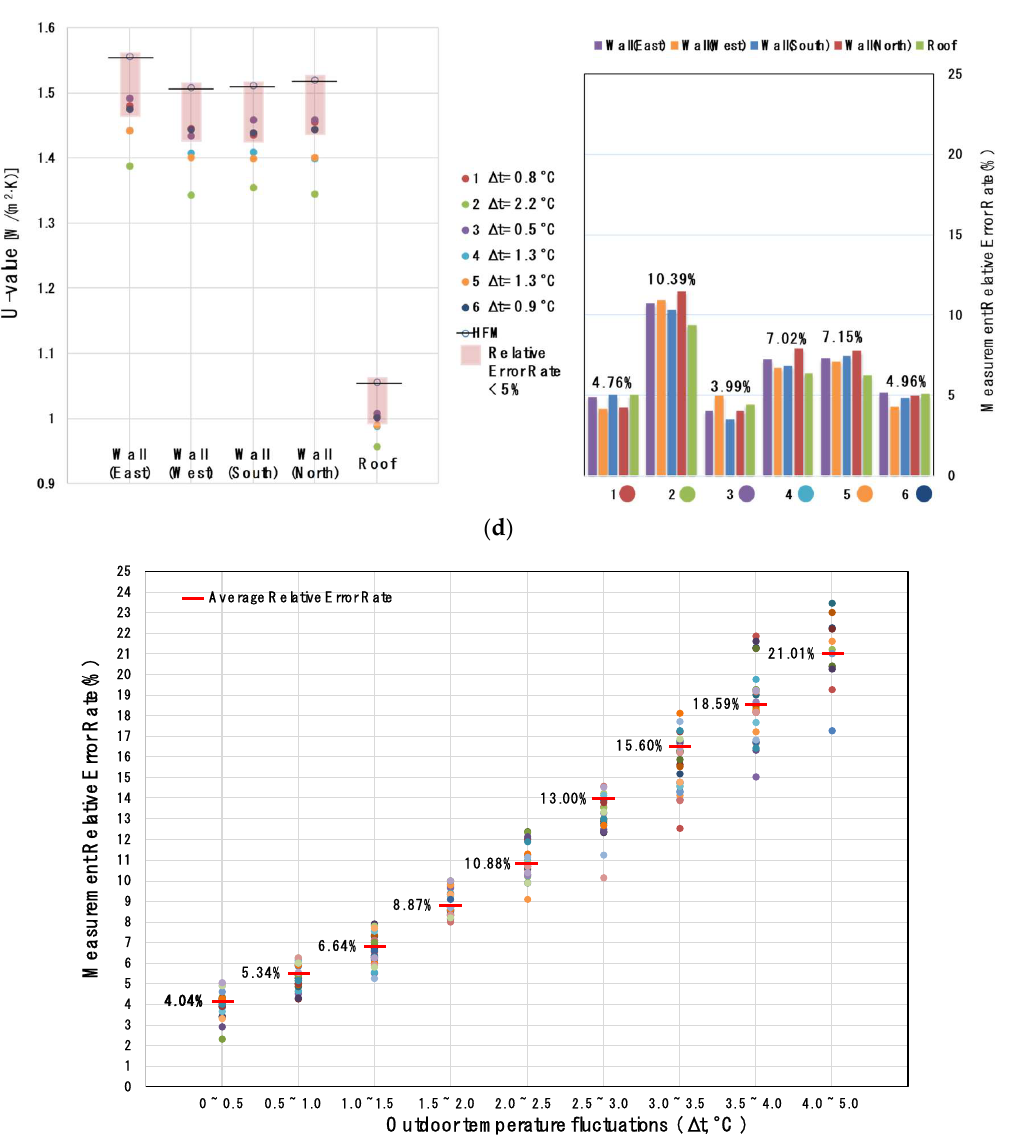
Figure 6. Relative error rate as a function of outdoor temperature fluctuation: ( a ) Case A; ( b ) Case B; ( c ) Case C; ( d ) Case D. Table 9. Relative error rate in the presence or absence of sampled data.